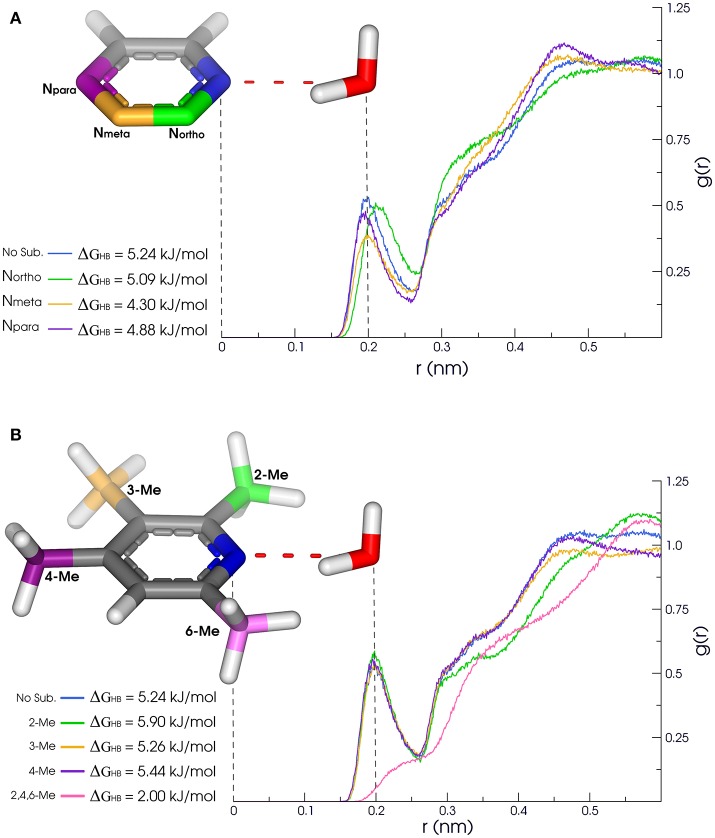
(A) Methyl substituitions: 2-Me (green), 3-Me (yellow), (B) Nearby N substitution: Northo (green), Nmeta (yellow), 4-Me (purple) and 2,4,6-Me (pink). Npara (purple). Solvation properties of aromatic rings in pyridine family. Radial distribution functions (RDFs) and H-bonding strength of N1 (blue) are affected by substitutions in ortho, meta, and para.